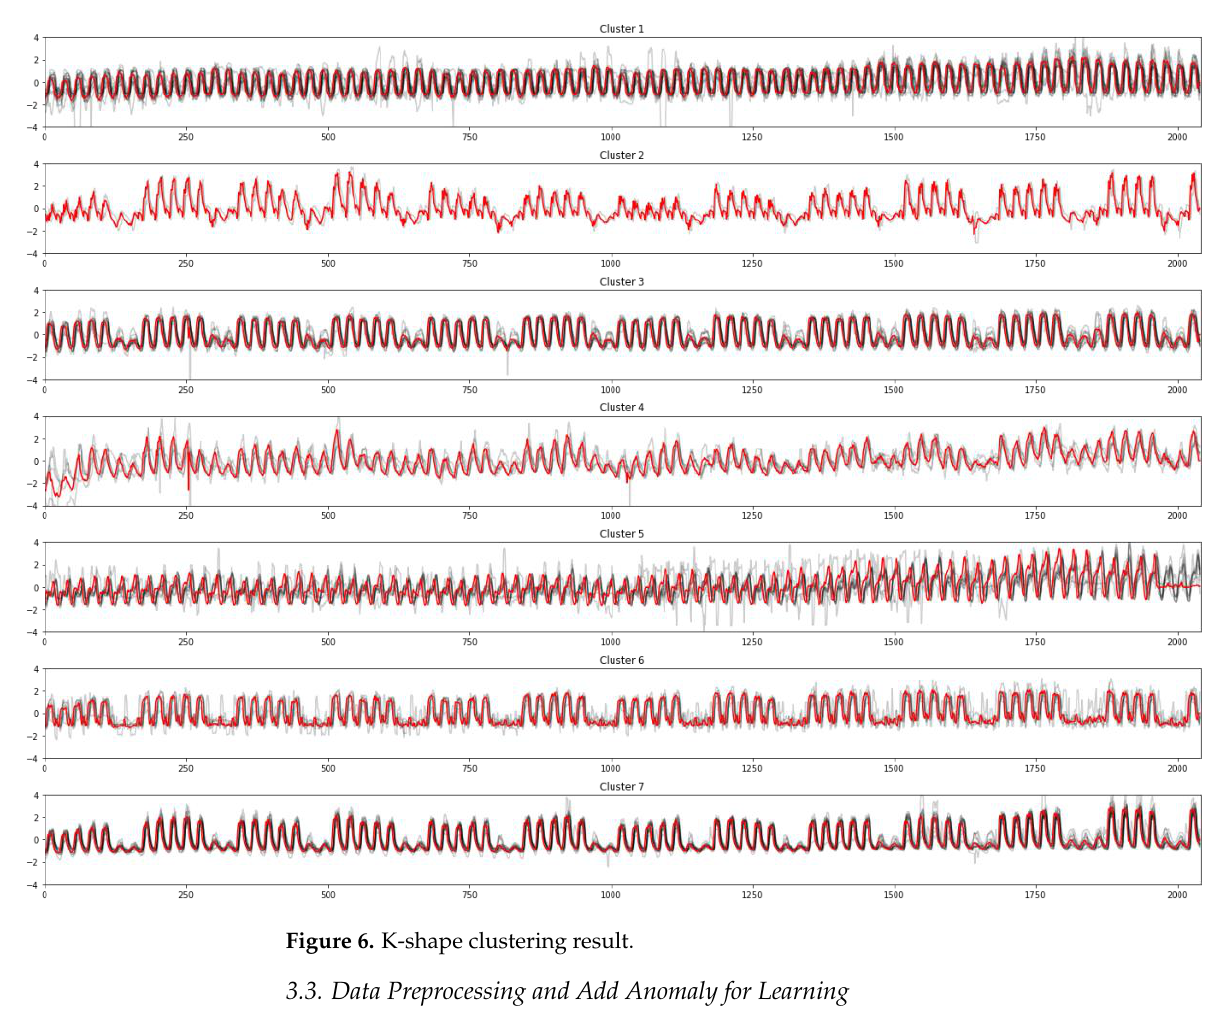
Figure 5. Result of elbow method to set k.